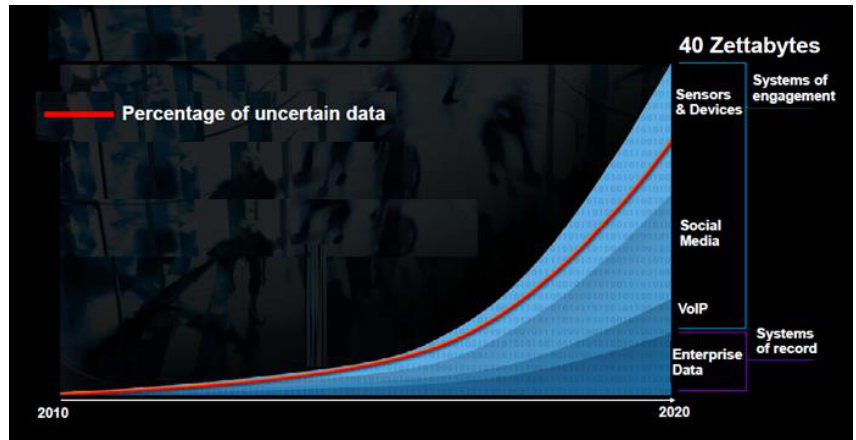
Figure 2: Projected Growth of Big Data (based on